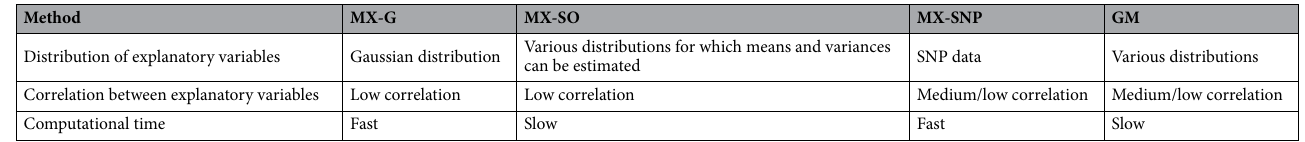
Table 4. Details of the use of MX-based and GM